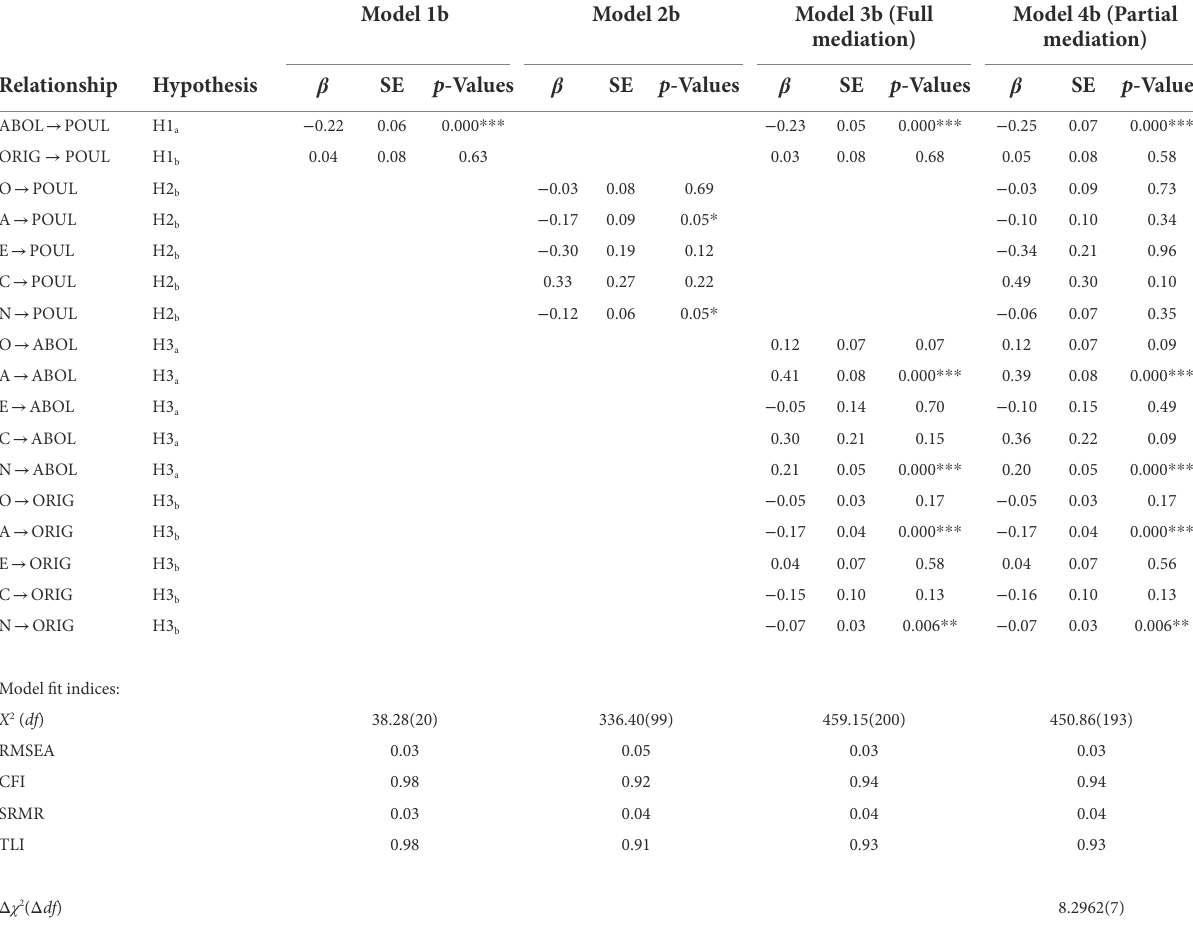
TABLE 3 Poultry consumption structural equation models and fit indices, controlling for sex and parental education